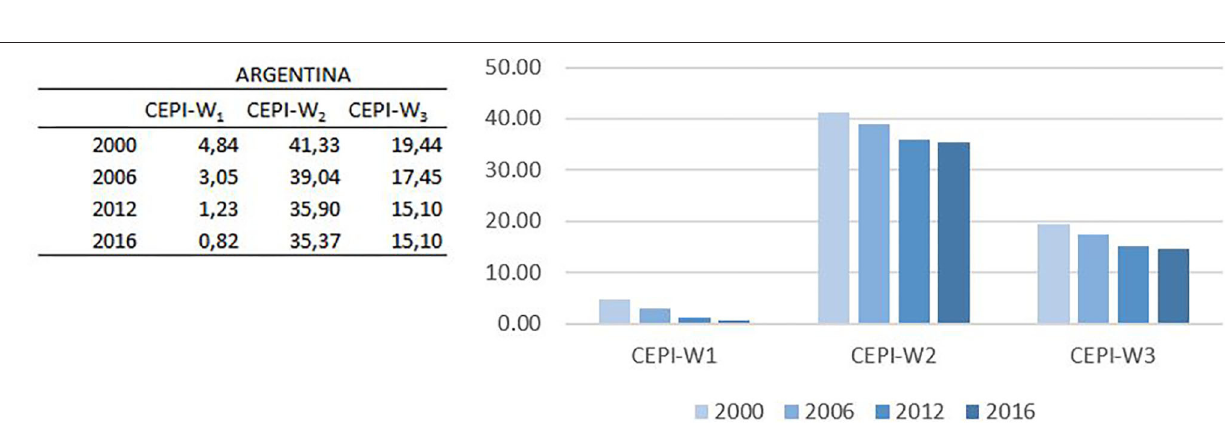
FIGURE 4 | CEPI — Argentina (2000, 2006, 2012, 2016).